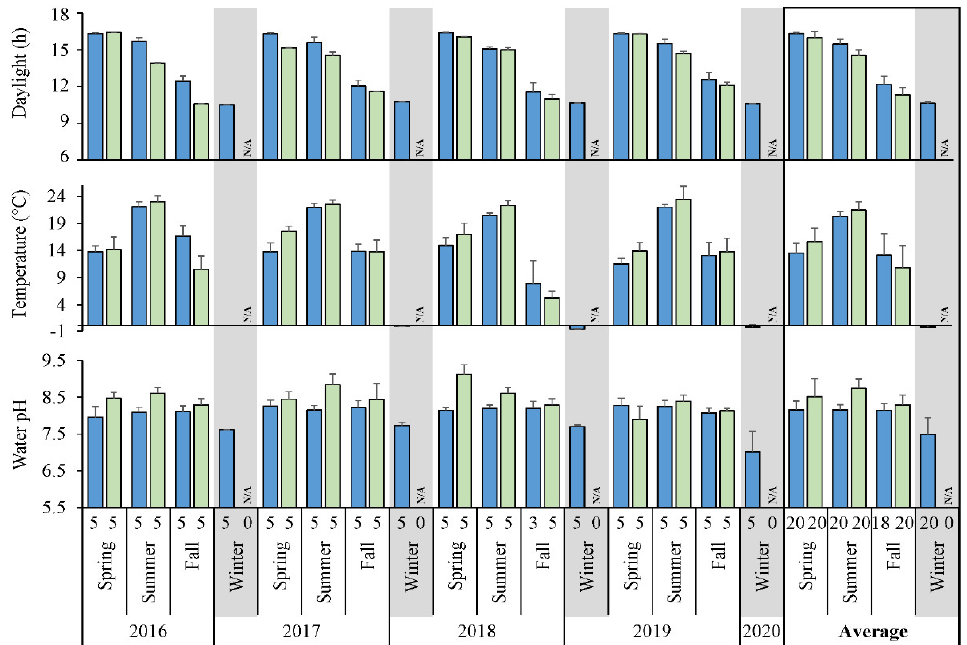
Figure 2 . Periodic fluctuations of lake environmental parameters. Average light availability, water temperature and pH for all limnetic (blue bars) or littoral (light green bars) samples depicted for each season. N/A, not analyzed; n, number of samples per season.